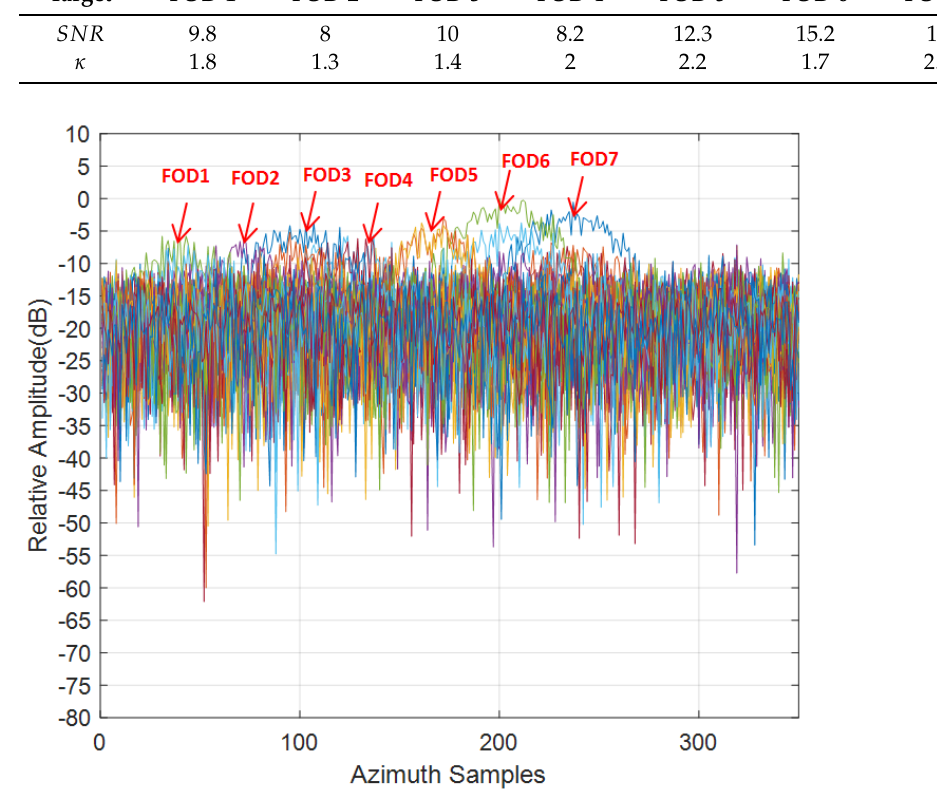
Figure 14. Test data obtained on azimuth direction, Scene 2.